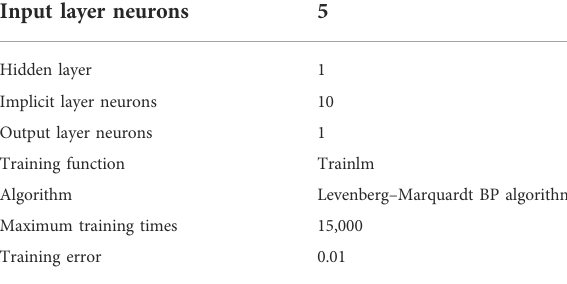
TABLE 1 Selection of neural network